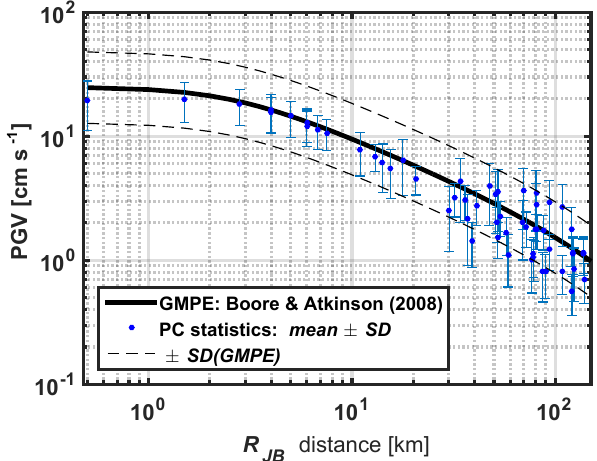
Figure 6. Comparison of PC statistics (based on uniform distri- bution assumption of the canonical PC random parameters) with GMPE results. Solid black curve denotes the median GMPE predic- tion, while the dashed lines are GMPE standard deviation bounds. Note that log scales are used in the plot.